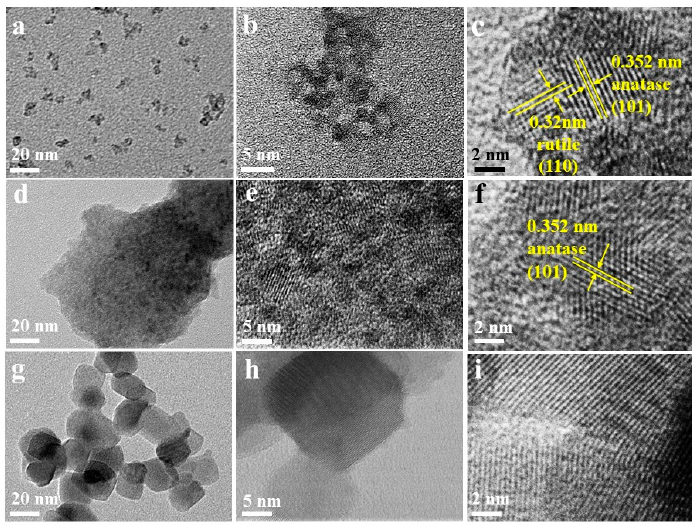
Figure 2. TEM images of ( a – c ) s-TiO 2 , ( d – f ) t-TiO 2 , and ( g – i ) P25.